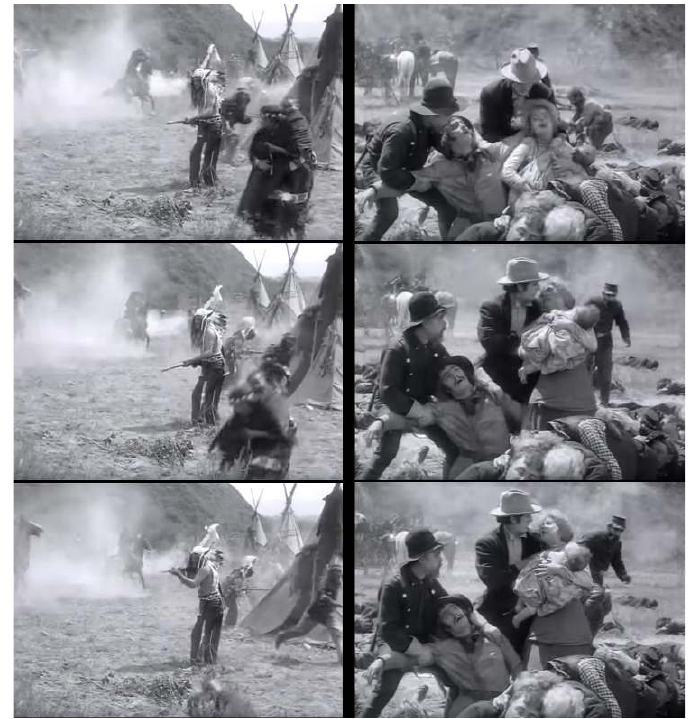
Figure 3. Stills from D.W. Griffith, The Massacre (1912), comparing the treatment of two women holding babies, one Indian (left), the other white